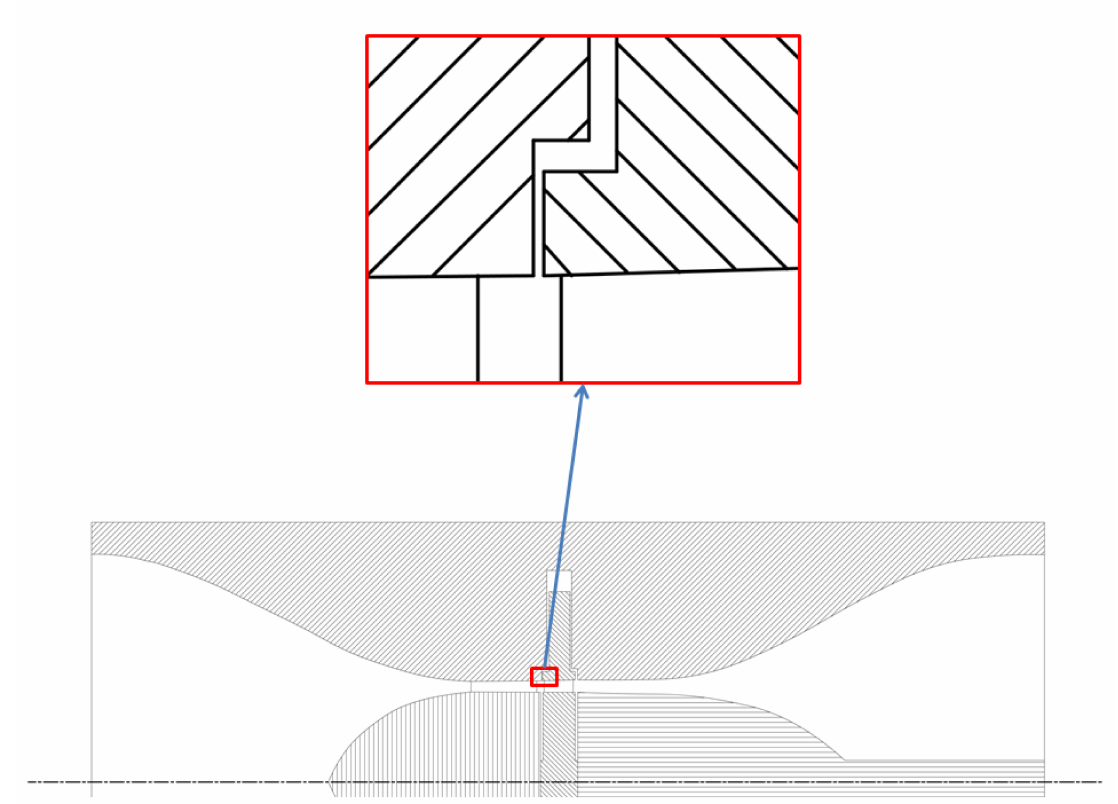
Figure 16. Cross section of the designed machine with a detail on the inlet section of the leakage mass